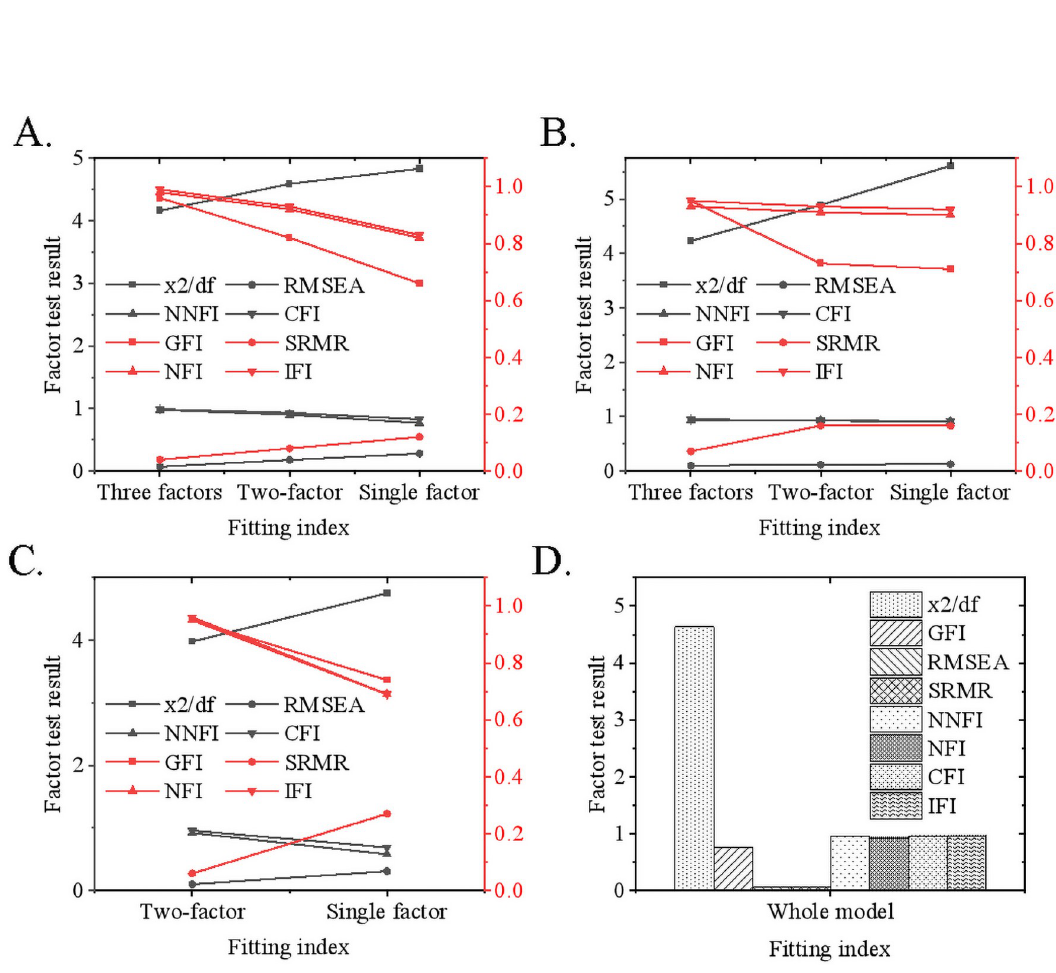
Fig 13. Fitting analysis results of the model performance in different data sets. Note: Fig 13-A represents the fitting indexes of CFA of career planning; Fig 13-B shows the fitting indexes of CFA of organizational support; Fig 13-C indicates the fitting indexes of CFA of career maturity; Fig 13-D shows the fitting indexes of CFA of the overall scale model.